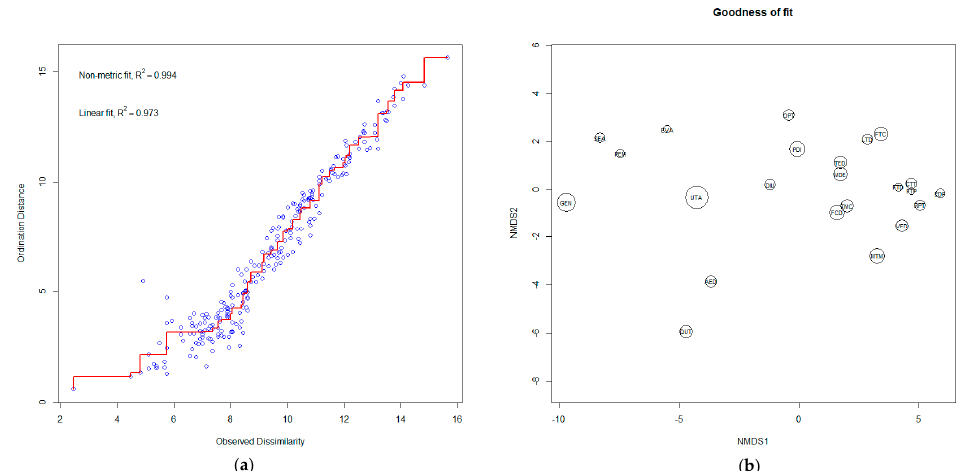
Figure 4. Non-metric multidimensional scaling analysis (NMDS). ( a ) Linear fit; ( b ) 316